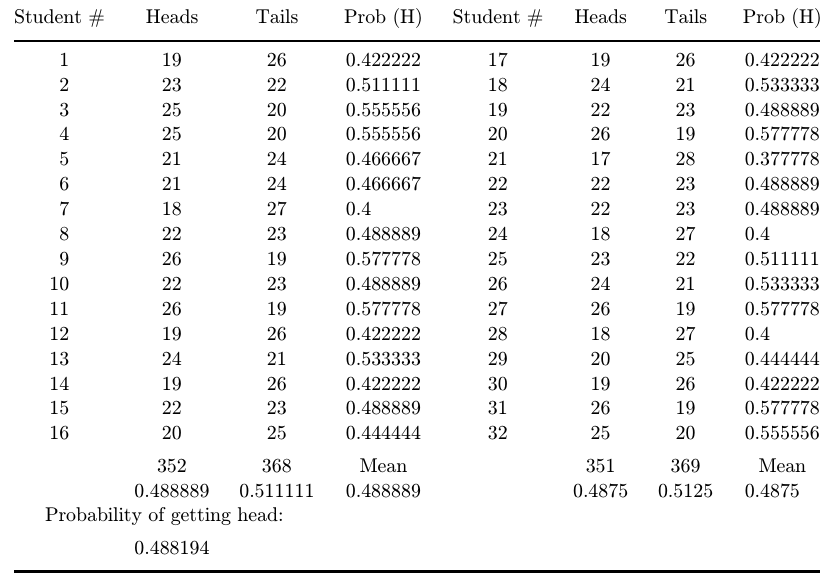
Table 2. Results for a group of 32 students, each °ipping the coin 45